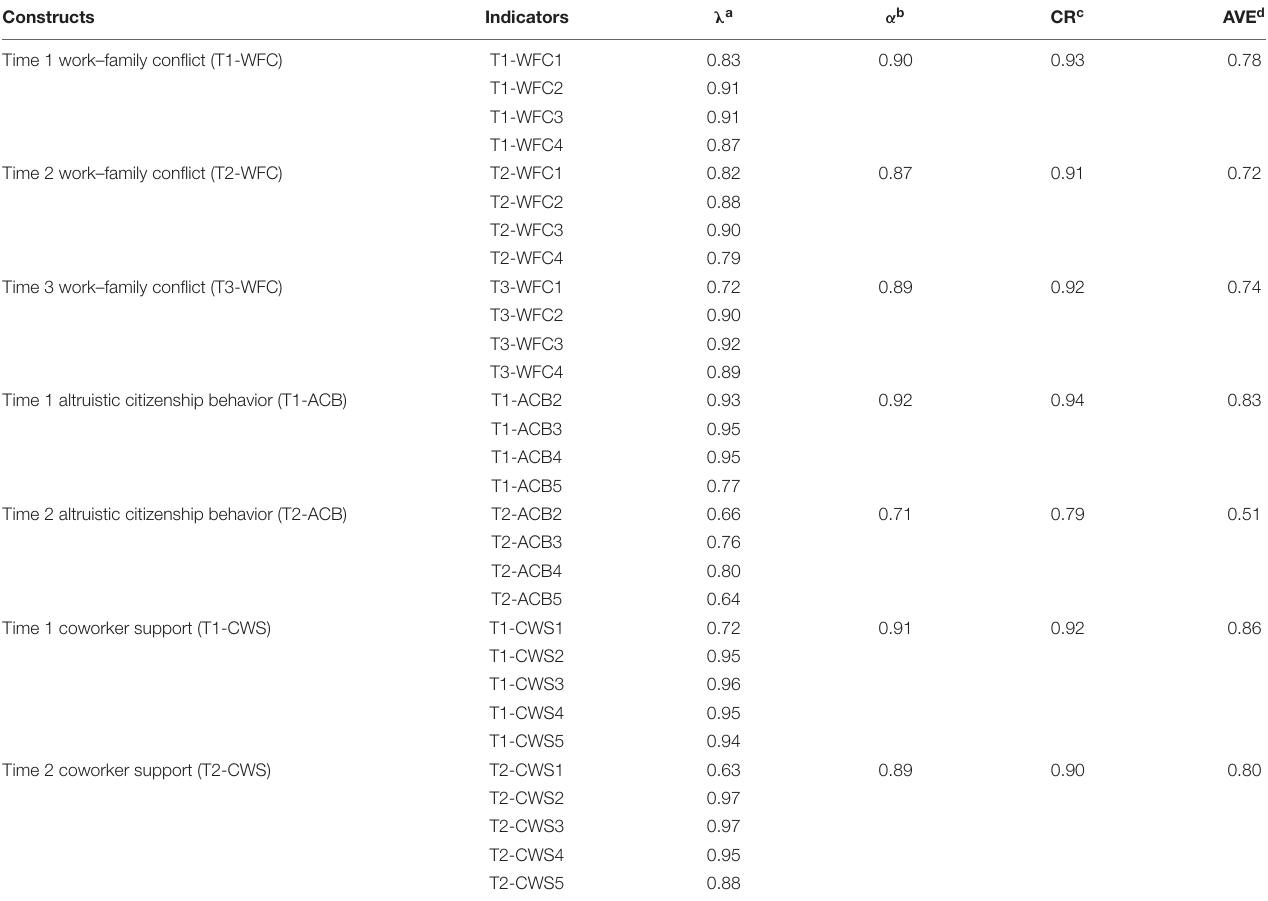
TABLE 2 | Evaluation of measurement